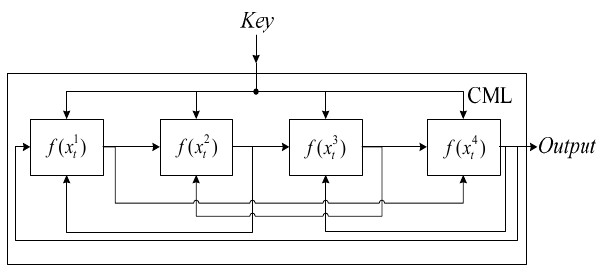
Figure 2. The structure of the original four stage CML based on the logistic map.